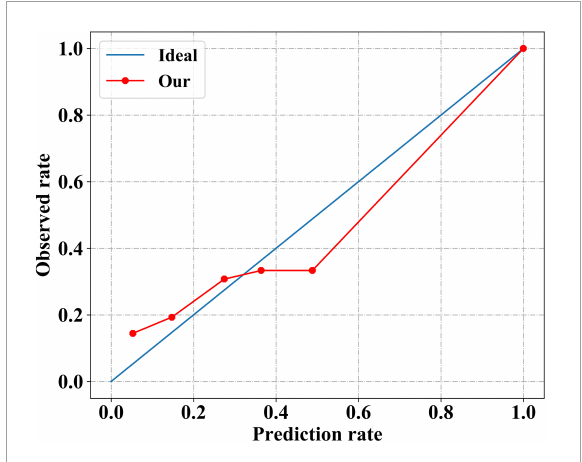
FIGURE4 Calibration performance of our neural network model. The solid red line indicates the calibration curve of our neural network model, which closely matches the blue ideal calibration